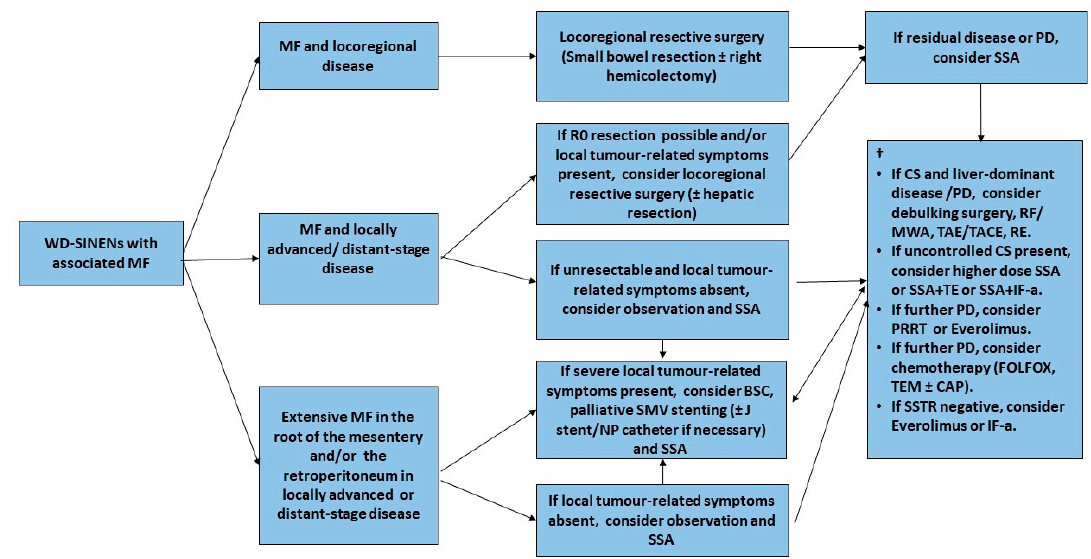
Figure 4. Management of Small Intestinal NENs with Mesenteric Fibrosis-Flow diagram. † Systemic treatment recommendations adapted from ESMO 2020 Clinical Practice Guidelines for diagnosis, treatment and follow-up of Gastroenteropancreatic Neuroendocrine Neoplasms [96]. Abbreviations. BSC: best supportive care; CAP: capecitabin; CS: carcinoid syndrome; FOLFOX: Folinic acid,